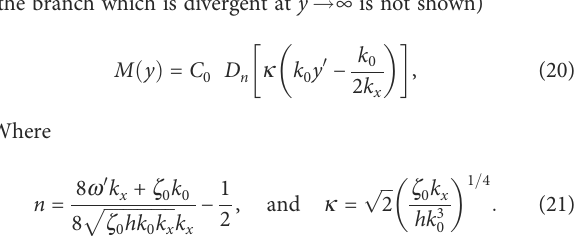
ffiffiffi p hk 2 = z : 2,1,5, respectively. Shaded areas indicate negative 2 0 = 0 0